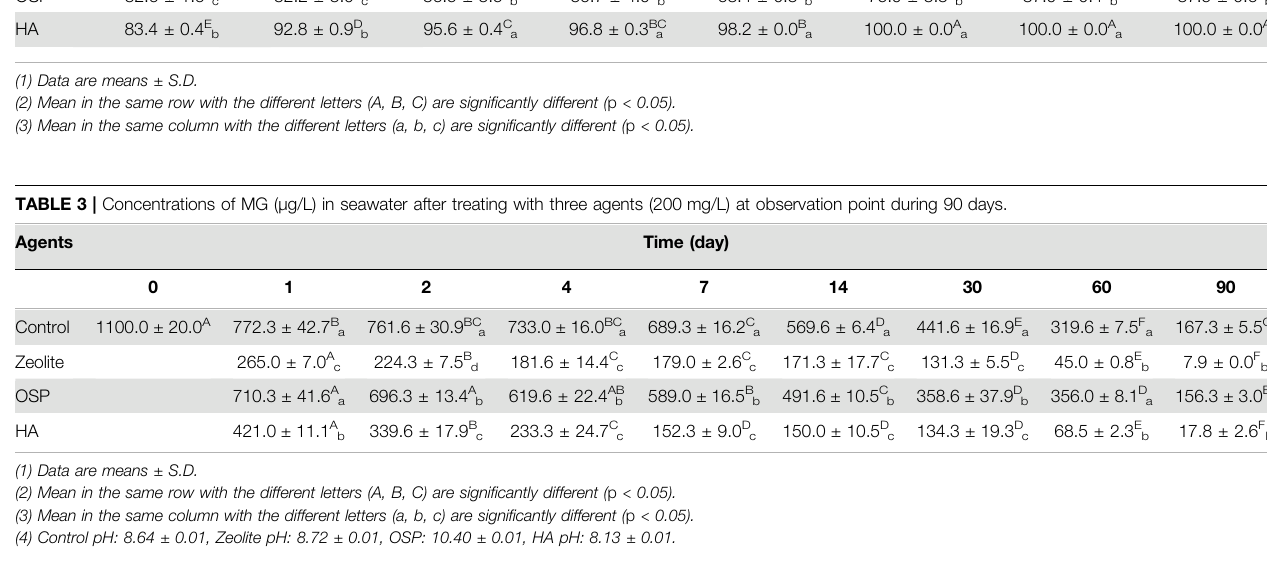
SOP, and HA, respectively ( Table 2 ). As shown in Supplementary Figure S3 , the adsorption capacity of three water agents in MG- containing freshwater were calculated as following: 65.0 mg/g for zeolite, 60.9 mg/g for OSP, and 65.0 mg/g for HA. These results suggest that zeolite and HA have a good adsorption capacity for MG in freshwater among the three tested agents.